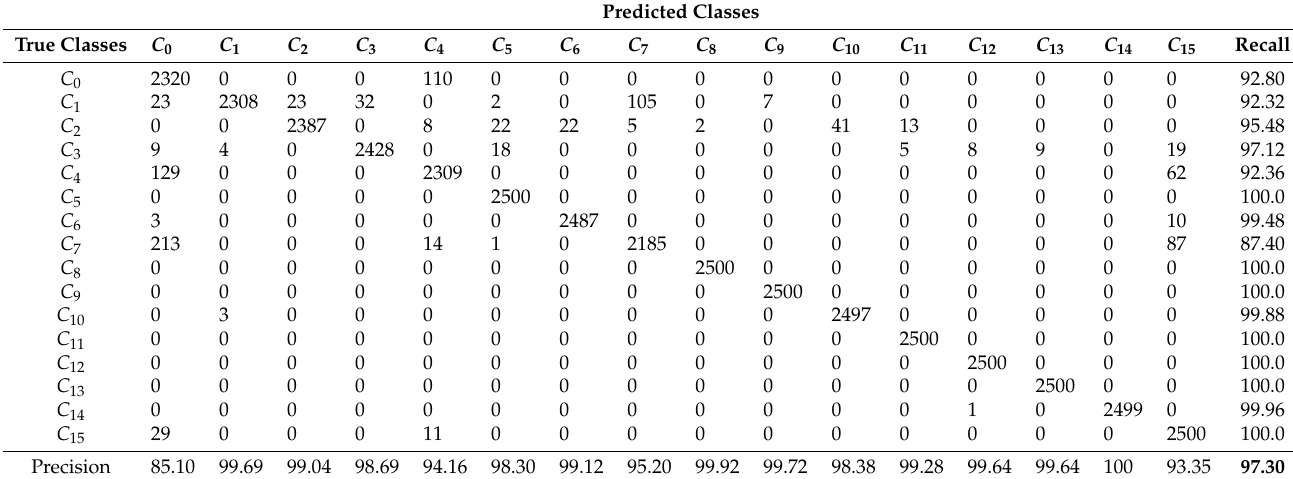
Table 9. Confusion matrix of KPCA-based BiLSTM in testing